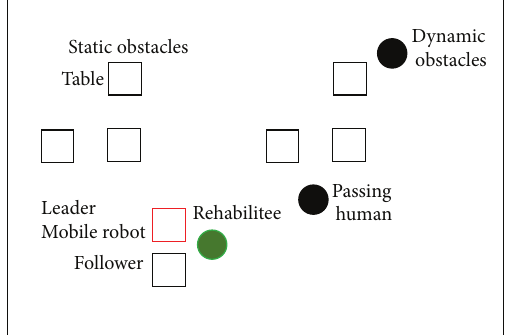
Figure 5: The initial condition of the human living